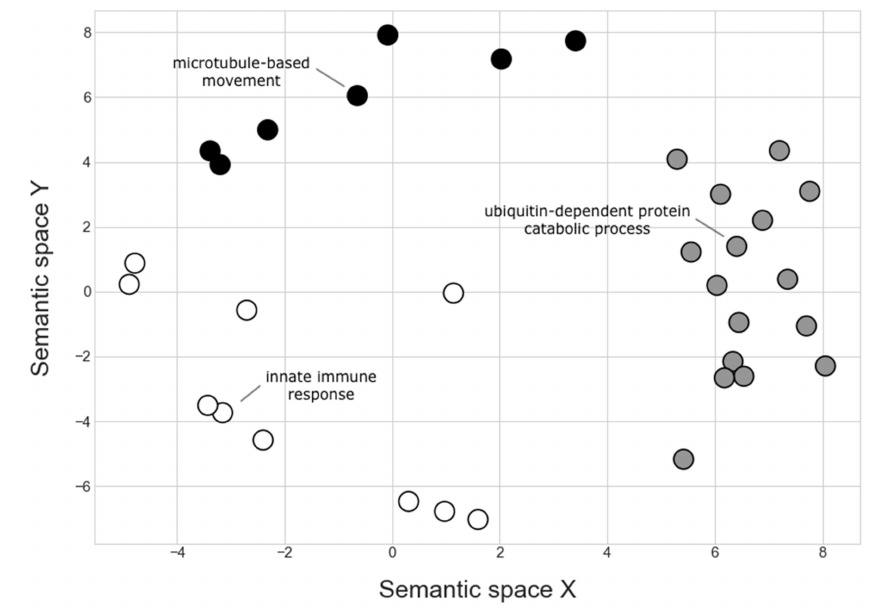
Figure 5. Scatter plot of the GO terms for biological process (n = 33) for the associated genes, summarized by multidimen- sional scaling on the semantic similarity matrix. Each point represents a GO term for a biological process, and its position in the scaled space of semantic similarities depicts its similarity of meaning relative to the other GO terms. Colors correspond to K-means clusters for an optimal K-value = 3. Labels correspond to GO terms that are nearest to each cluster center. A full list of the description of the GO terms and the Python code used to create this figure is provided in the form of a Jupyter notebook (Supplementary File